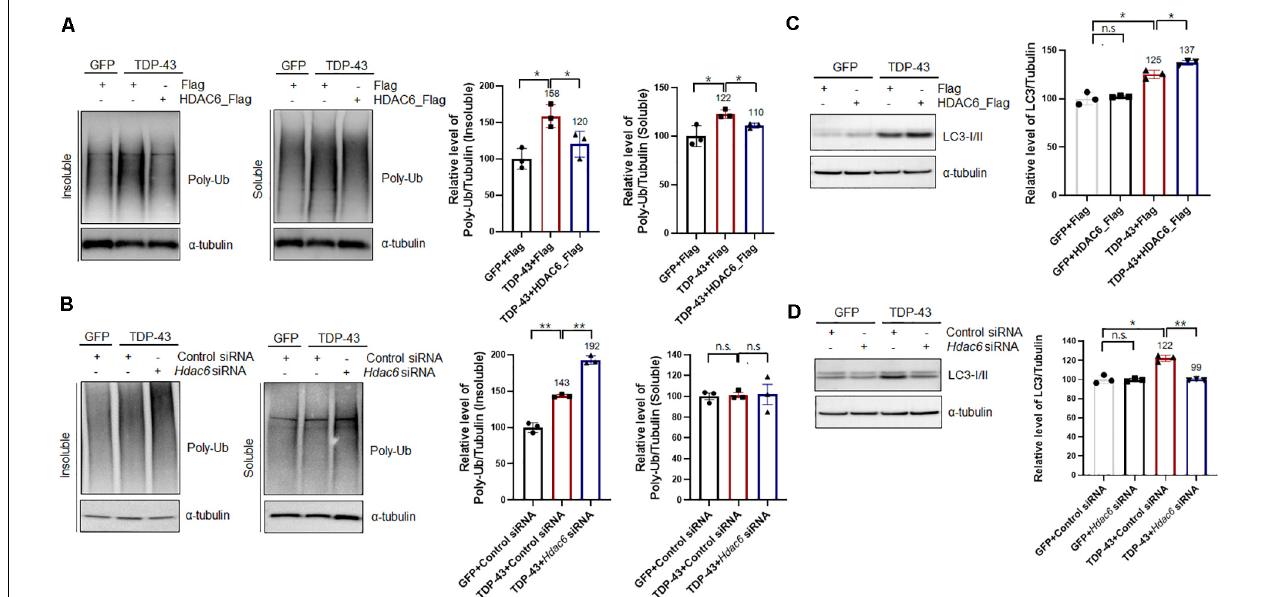
FIGURE 3 | HDAC6 mitigates TDP-43-induced UPS impairment via the autophagy-lysosome pathway. (A,C) Stable Flag- or HDAC6-Flag-expressing cells were transiently transfected with a plasmid containing either Gfp or TDP-43-Gfp and were then grown for 2 days. (A) Soluble and insoluble polyubiquitinated protein levels were significantly increased by TDP-43-GFP expression. HDAC6 overexpression significantly reduced TDP-43-induced polyubiquitinated protein levels. Cells were fractionated into the supernatant (the soluble fraction) and the pellet (the insoluble fraction) using lysis buffer containing 1% Triton X-100. Data are presented as the mean ± SD of three independent experiments. * p < 0.05 (one-way ANOVA with Tukey’s multiple comparison test). (C) Immunoblot analysis of an anti-LC3 antibody. HDAC6 overexpression markedly increased the level of TDP-43 in TDP-43-GFP-expressing cells. Data are presented as the mean ± SD of three independent experiments. * p < 0.05, n.s. , not significant (one-way ANOVA with Tukey’s multiple comparison test). (B,D) Control or Hdac6 knockdown cells were transiently transfected with a plasmid containing either Gfp or TDP-43-Gfp and were then grown for 2 days. (B) Soluble and insoluble polyubiquitinated protein levels were significantly increased by TDP-43-GFP expression. Hdac6 knockdown significantly increased TDP-43-induced polyubiquitinated protein levels. Cells were fractionated into the supernatant (the soluble fraction) and the pellet (the insoluble fraction) using lysis buffer containing 1% Triton X-100. Data are presented as the mean ± SD of three independent experiments. ** p < 0.005, n.s. , not significant (one-way ANOVA with Tukey’s multiple comparison test). (D) Immunoblot analysis of an anti-LC3 antibody. Hdac6 knockdown markedly decreased the level of LC3 in TDP-43-GFP-expressing cells. Data are presented as the mean ± SD of three independent experiments. * p < 0.05, ** p < 0.005, n.s. , not significant (one-way ANOVA with Tukey’s multiple comparison